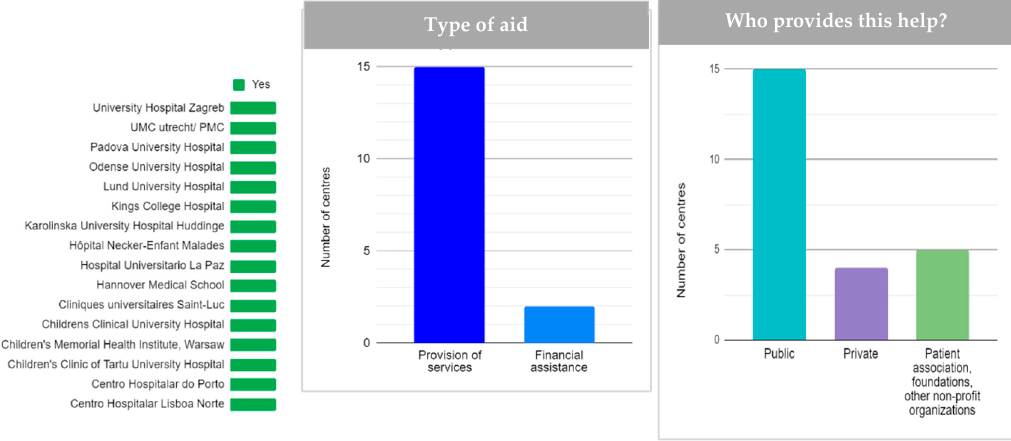
Figure 3. Economic aid for professional treatments (physiotherapy, speech therapy, early stimulation, psychological support, etc.). From left to right, availability, type of aid, and provider of these aids ( n = 15).